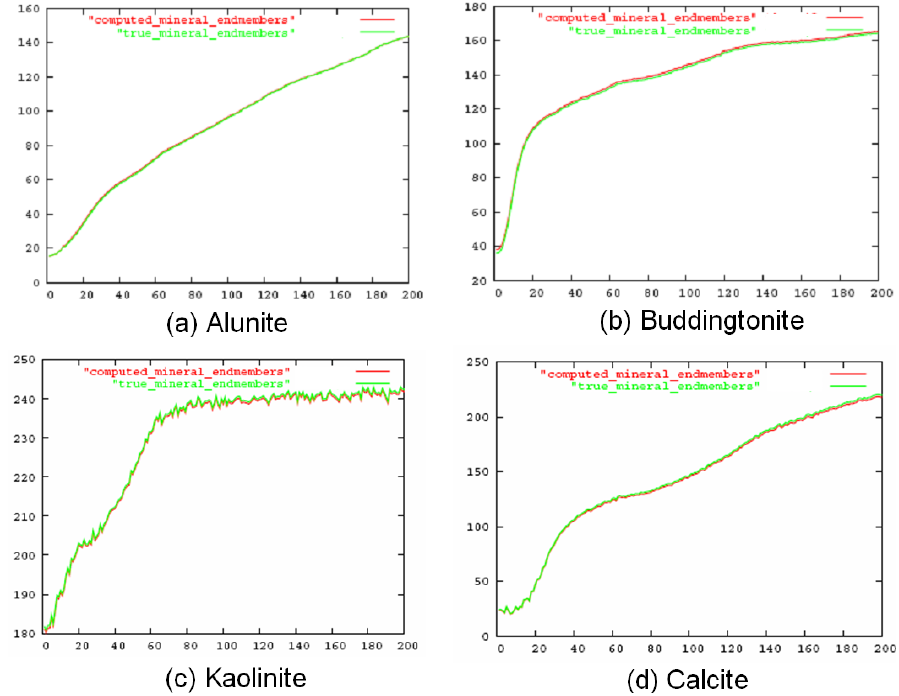
Figure 6. Comparison between the true endmembers and endmembers computed from the N-FINDR algorithm. (X-axis: band number, Y-axis: reflectance value.)